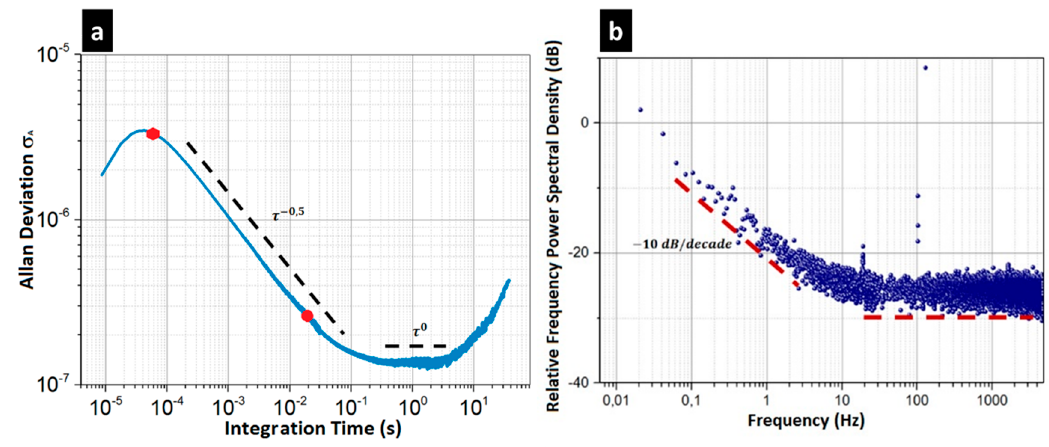
Figure 10. Noise characterization achieved on the typical electromechanical pixel—the amplitude at resonance is set at 320 µ V: ( a ) Allan deviation measurement; the red hexagon indicates the frequency deviation for f BW = 7 kHz ( σ A = 3.5 × 10 − 6 ) and the red disk is the one for f BW = 50 Hz ( σ A = 3 × 10 − 7 ) ; a plateau is reached between 50 and 200 ms integration time ( σ A = 1.5 × 10 − 7 ); beyond 200 ms, a strong drift effect can be observed; ( b ) spectral power density measurement achieved on the same device. The Allan deviation has a τ − 1 2 stop at a short integration time corresponding to the signature of a White amplitude noise. Beyond 50 ms integration time, the Allan deviation presents a plateau, which shows a 1/ f frequency noise. These two noises can also be distinguished on the power spectral density: the slope of − 10 dB/decade corresponds to this plateau.